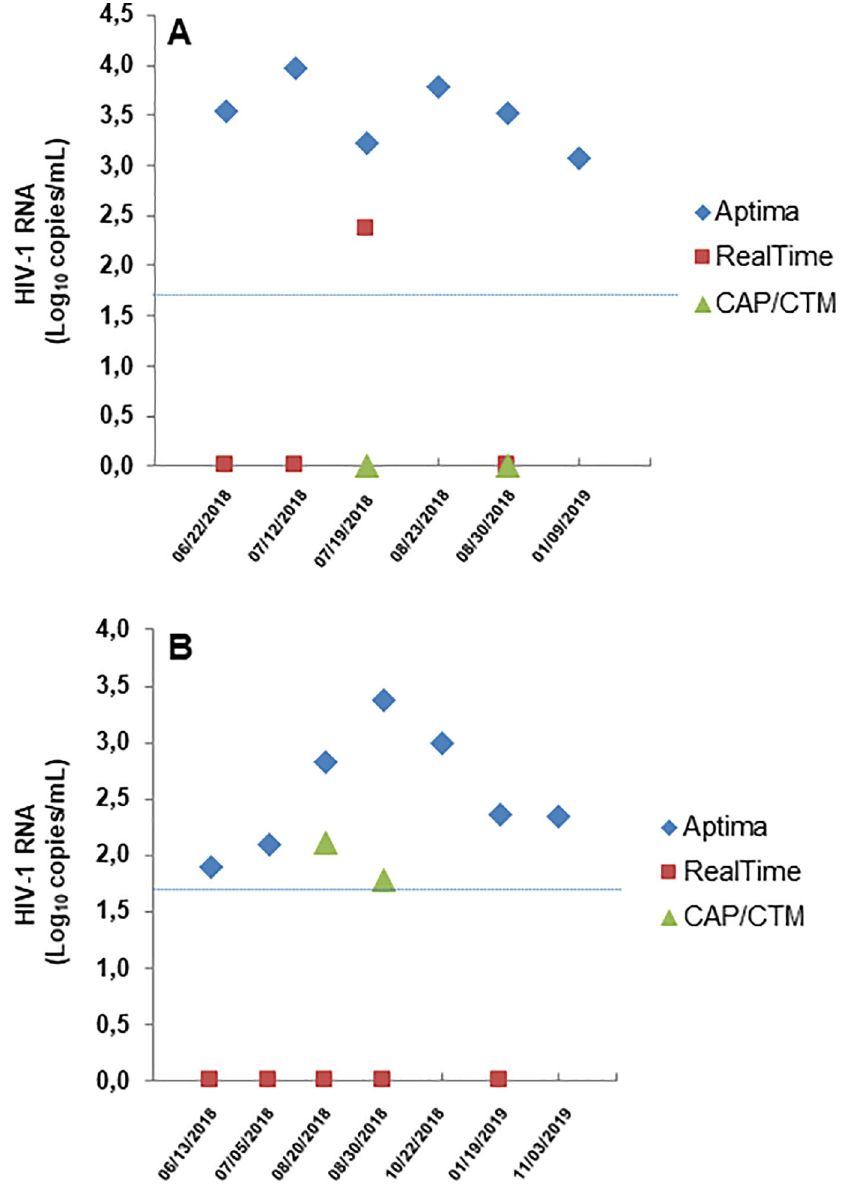
Fig 3. Comparison of HIV-1 VL obtained with Aptima, Real T ime and or CAP/CTM in longitudinal samples from two patients with HIV-RNA detected only with LTR signal. Residual plasma samples quantified with LTR region by Aptima were re-tested with Real T ime (n = 4 for patient A and n = 5 for patient B) and CAP/CTM (n = 2 for both patient A and B). Symbols: red square, Real T ime result; green triangle, CAP/CTM result; blue diamond, Amtima LTR- based result. Light blue dot line indicates the conventional suppressed viremia, i.e. 50 copies/mL HIV-1 RNA.